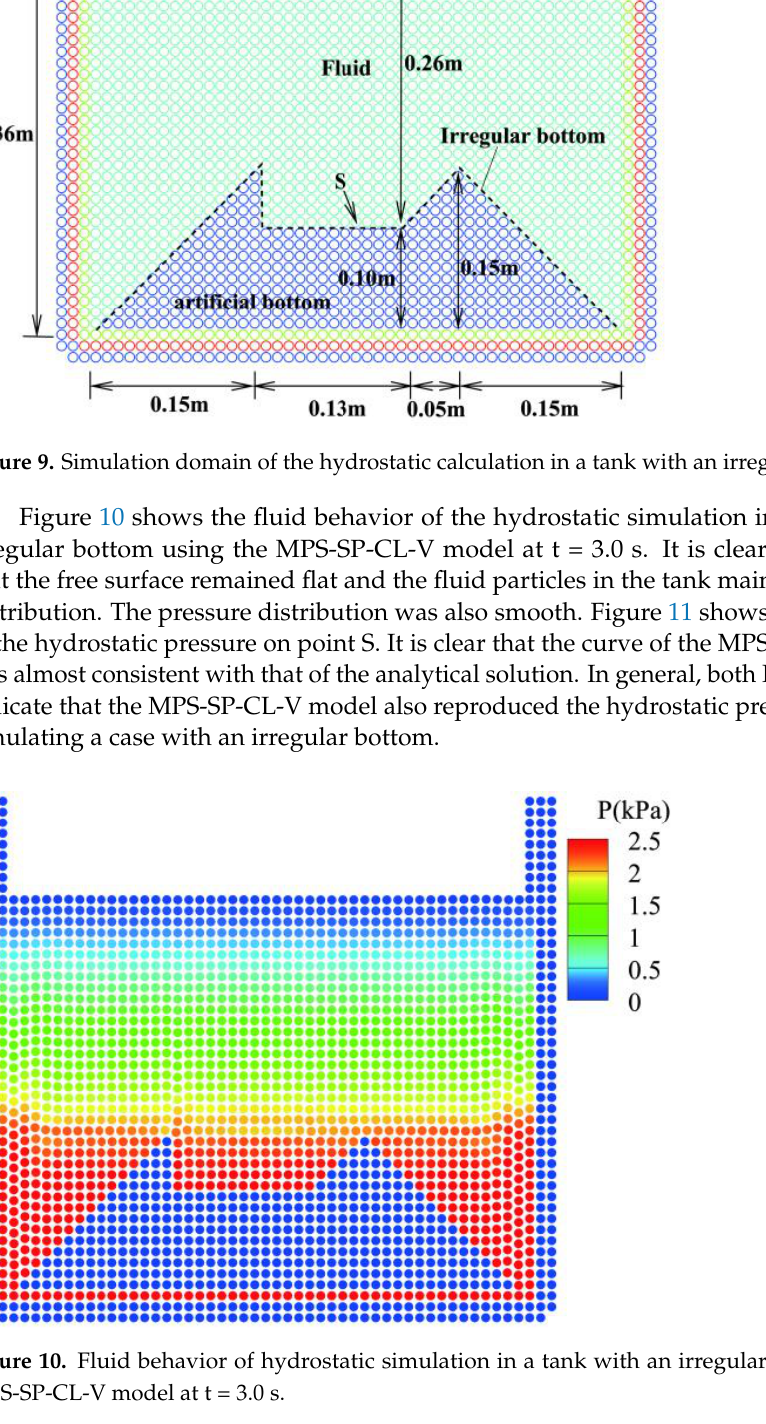
Figure 10. Fluid behavior of hydrostatic simulation in a tank with an irregular bottom using the MPS-SP-CL-V model at t = 3.0 s.